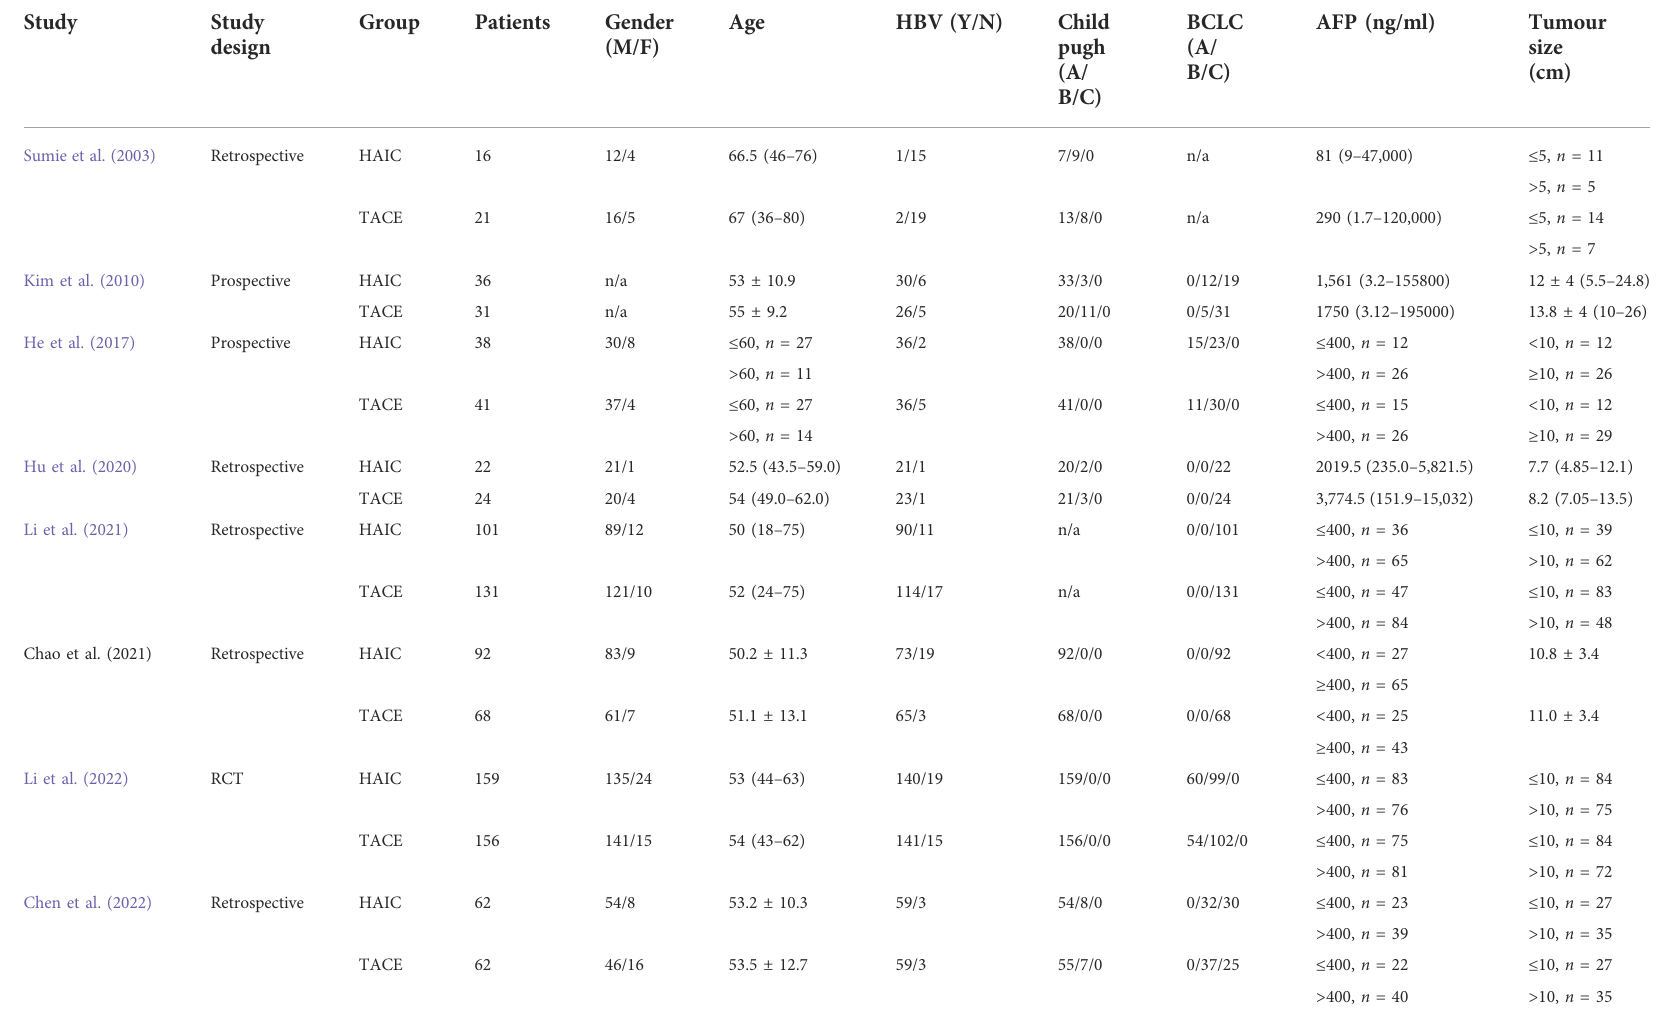
TABLE 1 Baseline characteristics of included studies in the